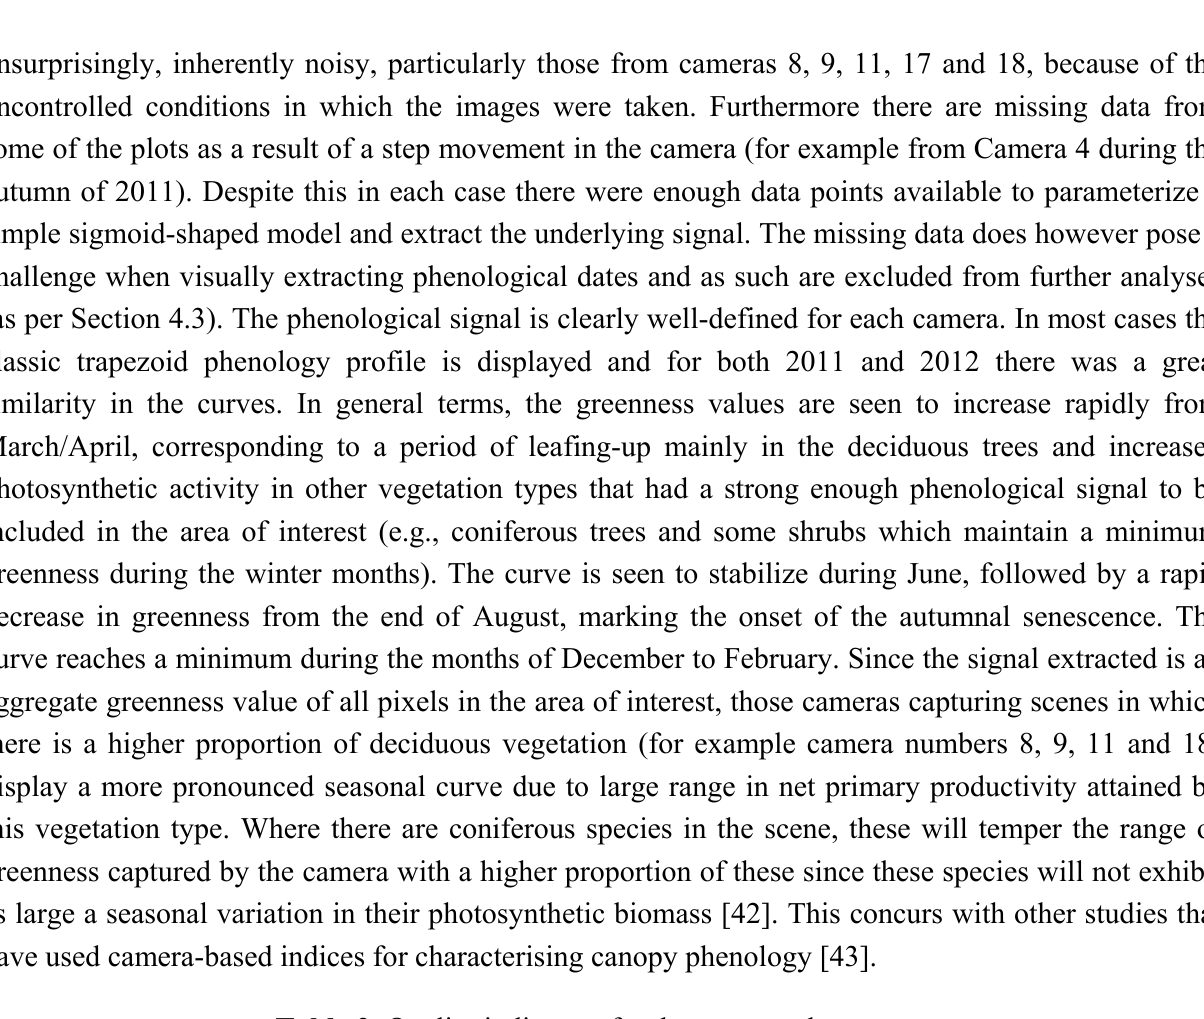
Table 2. Quality indicators for the processed